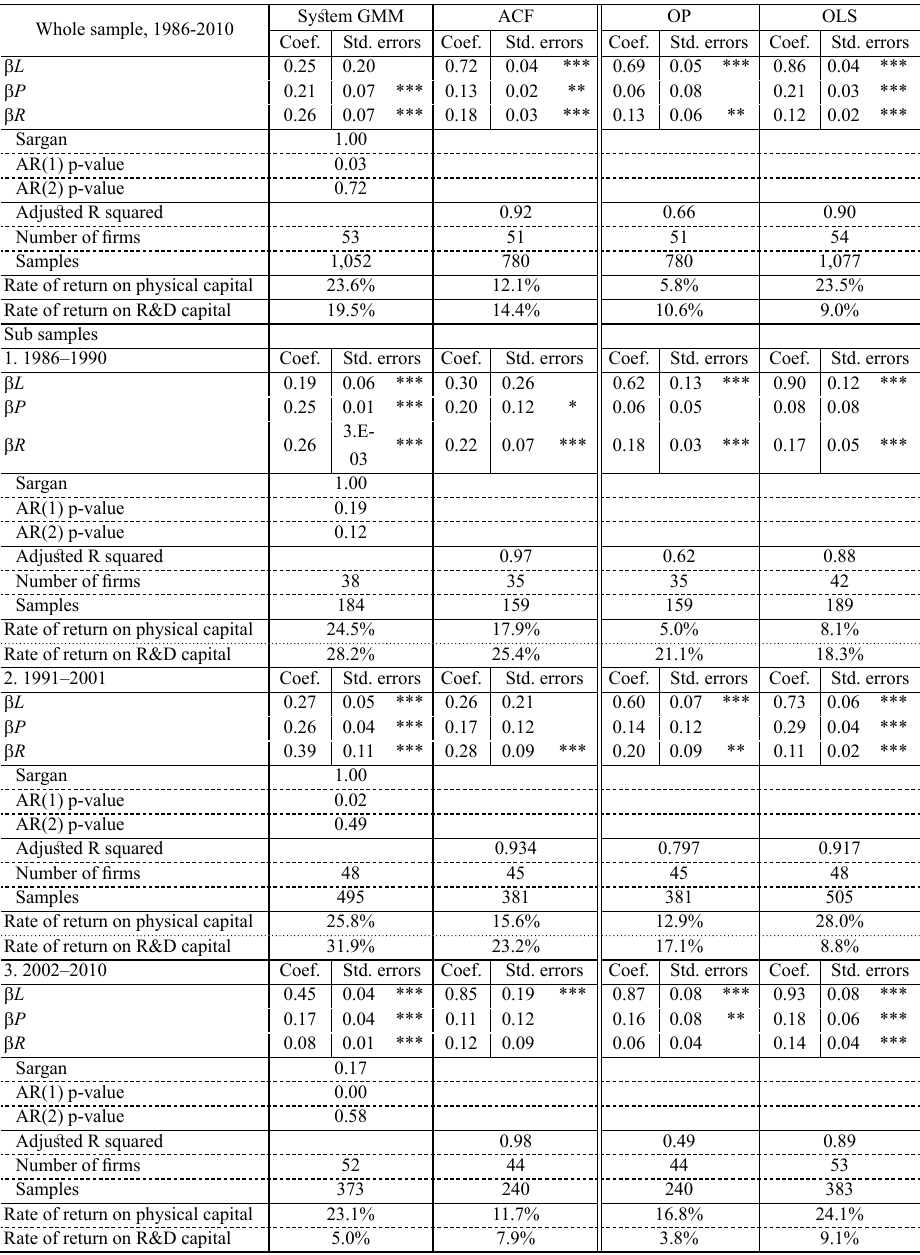
Table 4. Comparison of results from the four estimation methods for pharmaceutical firms Whole sample,